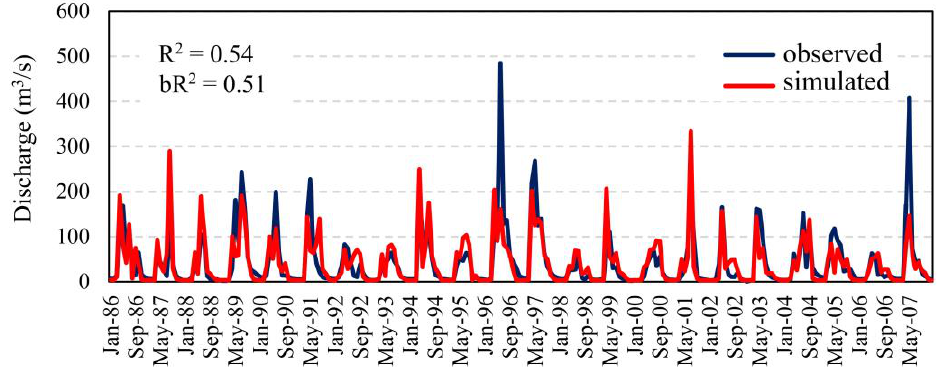
Figure 7. Comparison of the monthly simulated vs. observed streamflow for the watershed outlet (Outlet Gauge in Figure 3).